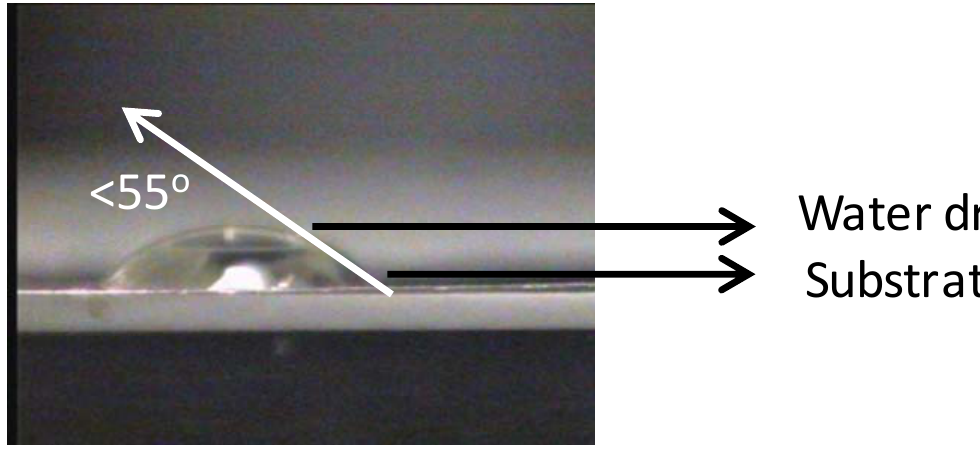
Figure 9. Water droplet on top of a thermally cleaned Ni-5% W